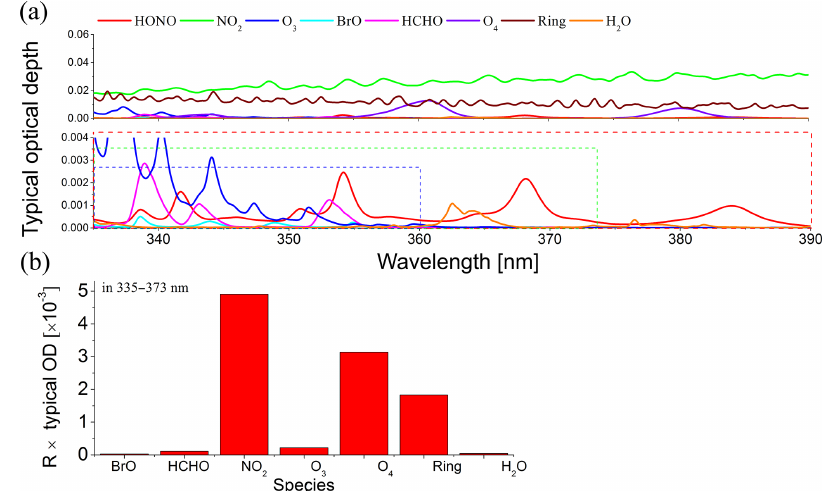
Figure 11. (a) Typical optical depths of the absorption species as the function of wavelength in the wavelength range for HONO retrieval; the dashed coloured squares in the lower subplot indicate the wavelength ranges 335 up to 360, 373 and 390nm, respectively; (b) correlation coefficients of the different cross sections multiplied with typical optical depths of respective species (based on the measurements during the whole campaign) with the HONO cross sections in the spectral range